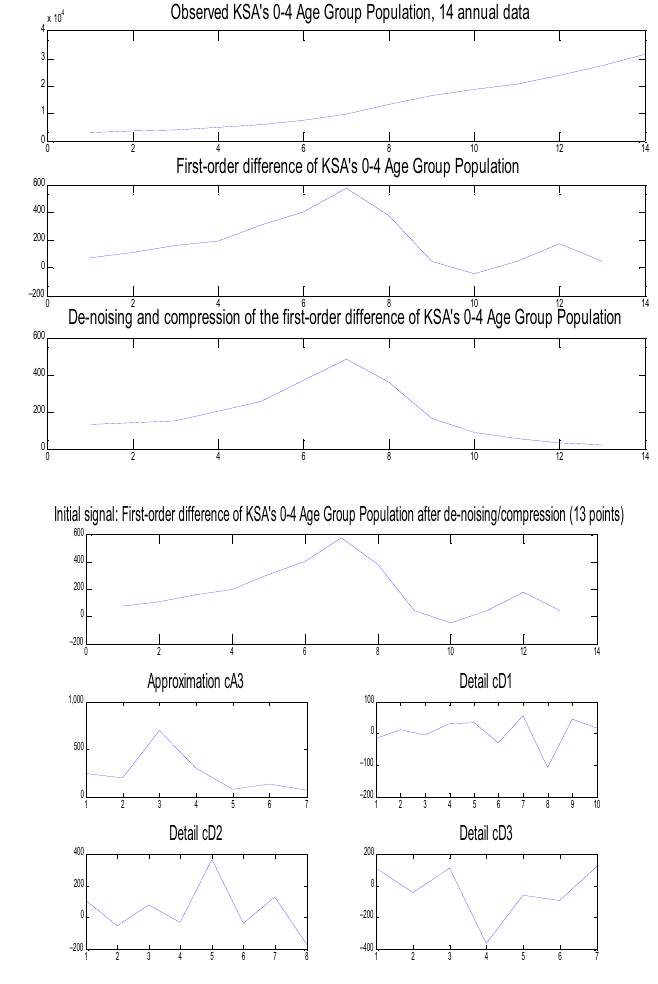
Figure 4. Third-level decomposition of the transformed KSA ’ s 0-4 age group population at current prices (after differentiation and de-noising/ compression) using one-dimensional discrete wavelet